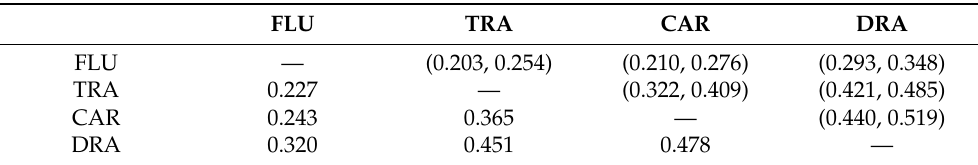
Table 3. Within-population genetic estimates in Esox spp. Pairwise population differentiation estimated using Weir and Cockerham’s θ